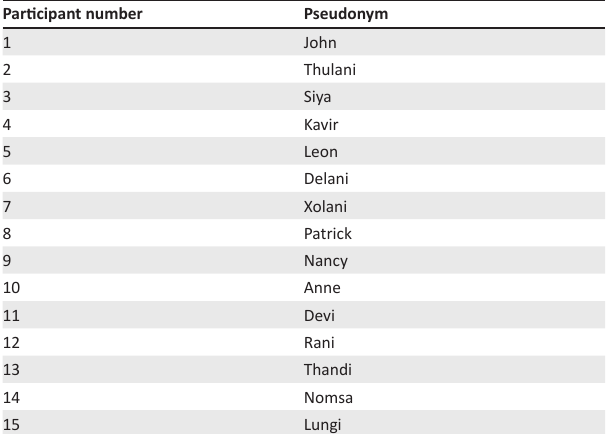
TABLE 1: The 15 postgraduate mathematics education students who participated in the discussion